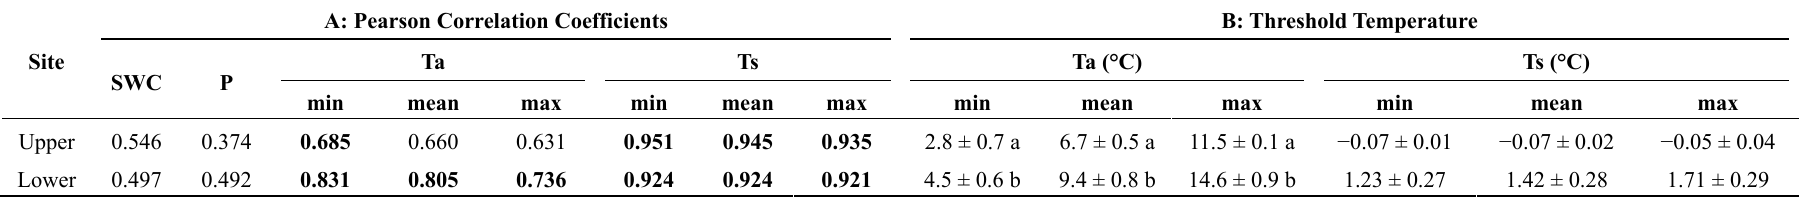
Table 3. Climate-growth relationship of Larix principis-rupprechtii at the upper and lower distribution limits in 2011. ( A ) Pearson correlation coefficients between total cell numbers and environmental factors in the period from the date of the onset of xylem growth to the date of the maximum growth rate. ( B ) Threshold daily minimum, mean and maximum temperatures of air and soil. The total cell numbers were the number of cells produced during one weekly interval based on the Gompertz function. The threshold temperature was the given daily temperautre with the 0.5-probability of cambium being active for the onset in spring. A: Pearson Correlation Coefficients B: Threshold Temperature Site SWC P Upper Abbreviations : SWC = Soil Water Content, P = Precipitation, Ta = Air Temperature, Ts = Soil Temperature; Significant correlation ( P < 0.05) are marked bold; letters (a, b) indicate significant differences between two sites based on Mann–Whitney rank-sum Test ( P <